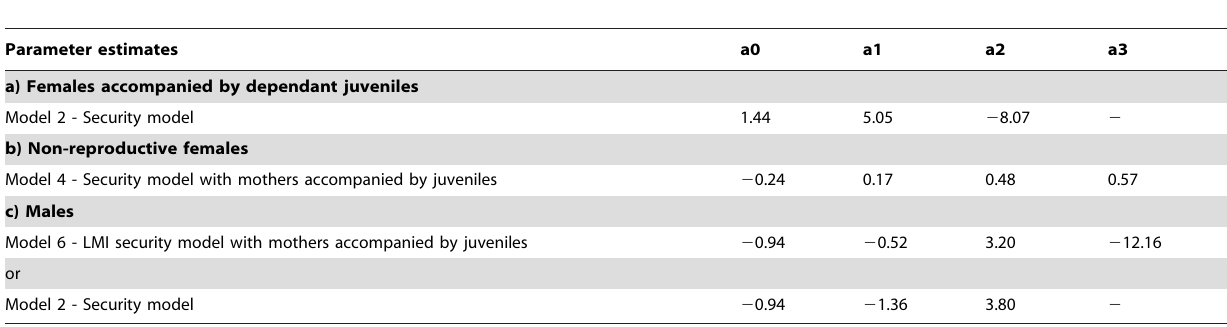
Table 3. Parameters estimates for the selected best-fitting candidate models for a) females with dependant juveniles, b) females without juvenile and c) males.